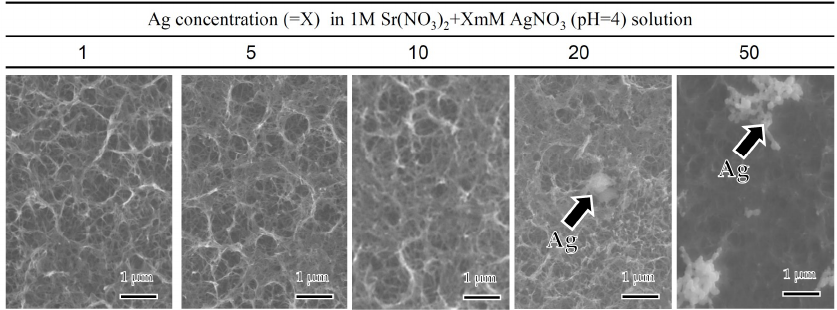
Figure 5. SEM images of the surfaces of Ti subjected to Sr + X mM Ag (pH = 4) treatment ( X = 1–50) following NaOH, Ca + Sr and heat treatment.